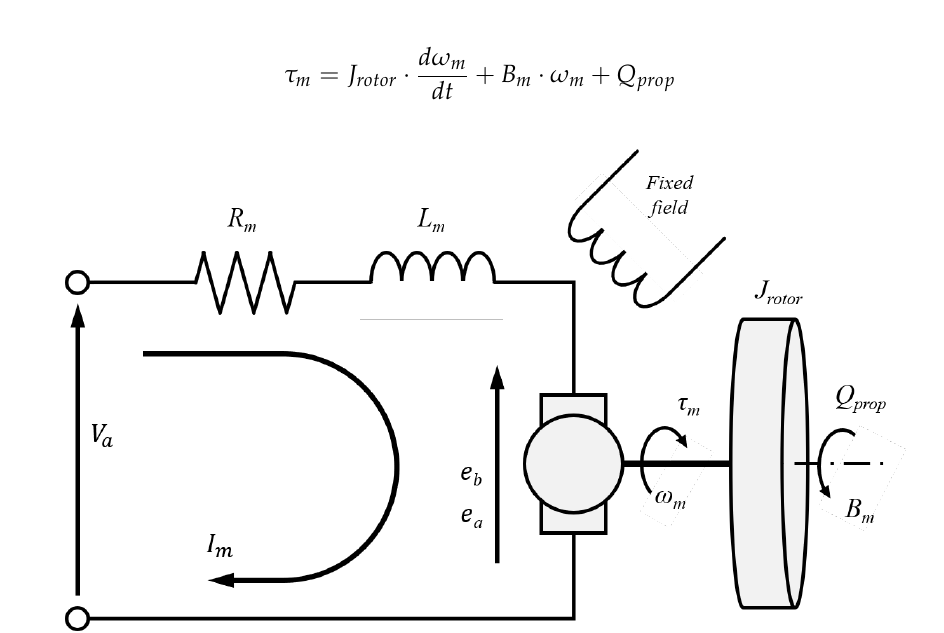
Figure 3. Equivalent circuit of DC